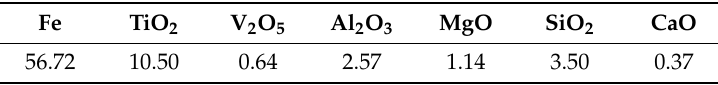
Table 2. Chemical compositions of the titanomagnetite concentrate (wt